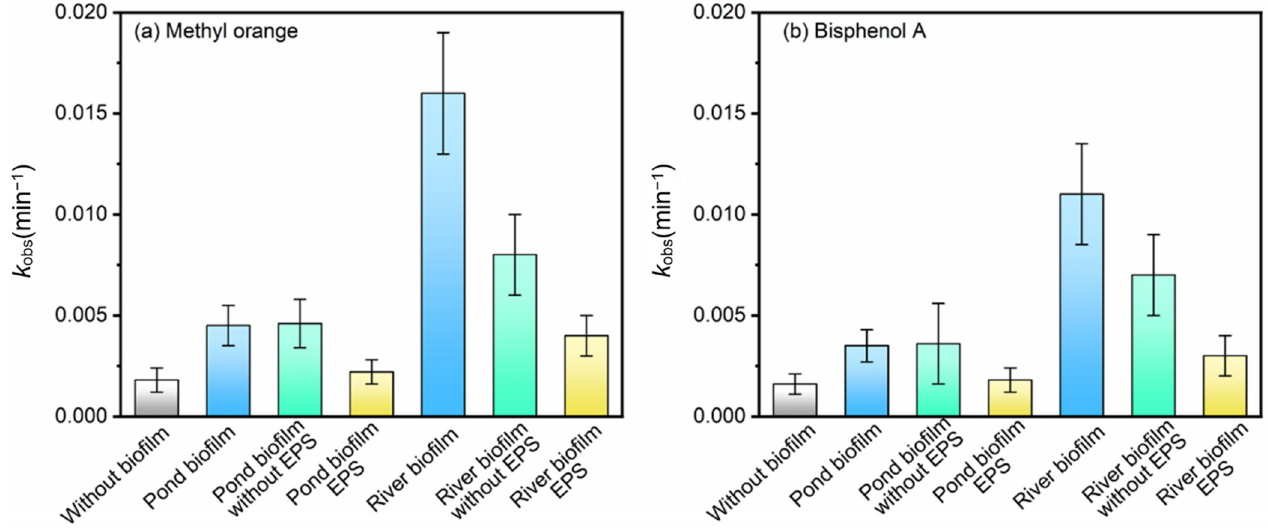
Figure 8. Comparison of kobs values of ( a ) OM and ( b ) BPA in the presence of different fractions in biofilms.